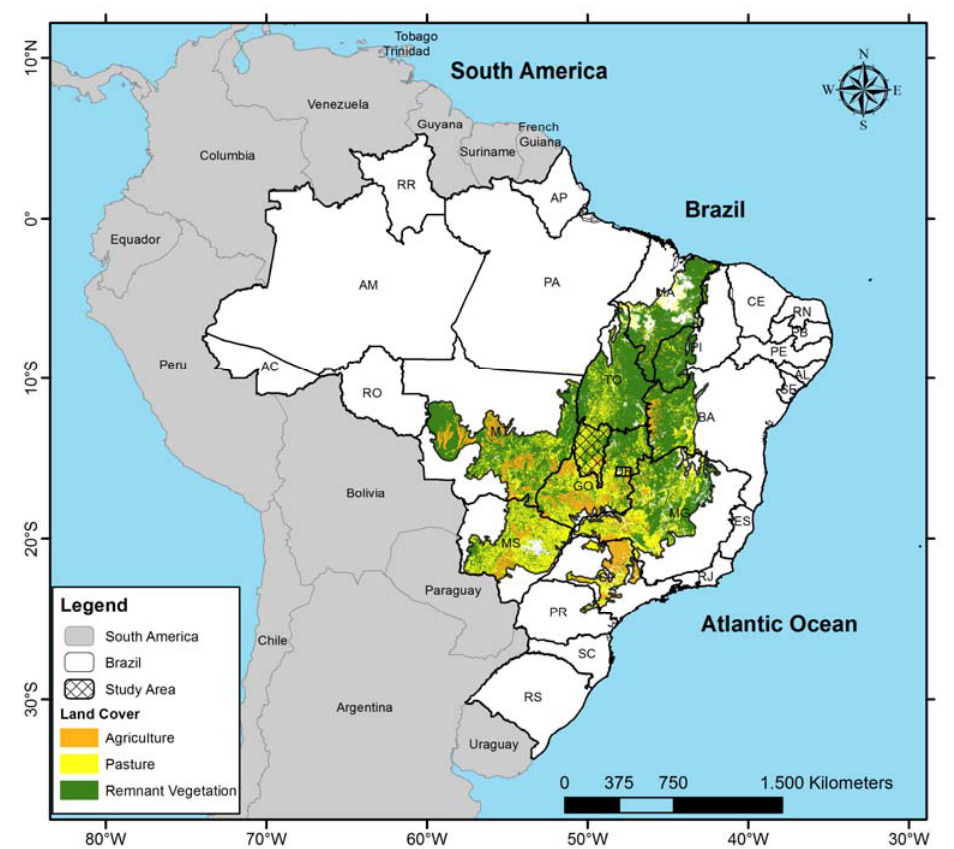
Figure 1. Spatial distribution of cultivated pastures in the Cerrado biome (with selected field sites highlighted). Source: